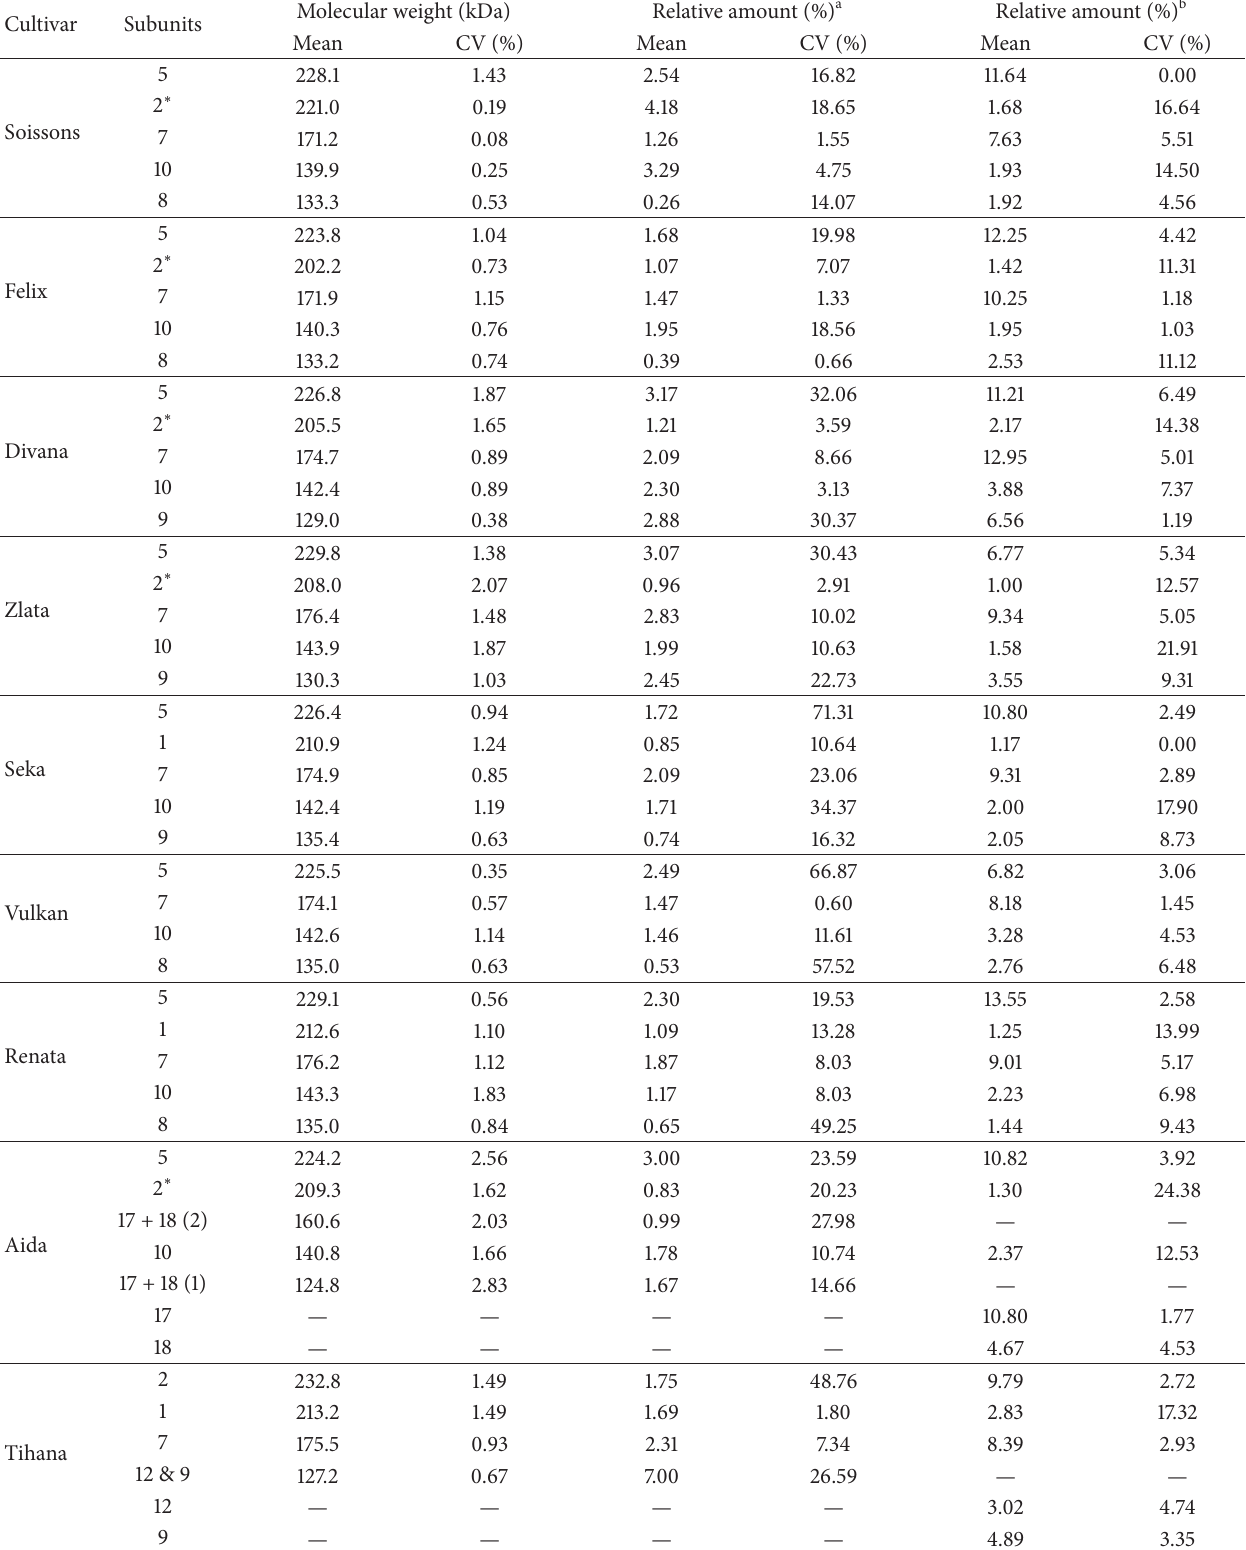
Table 2: Apparent sizes and quantification of individual HMW-GS subunits of nine bread wheat cultivars grown in Croatia by LoaC method and quantification of individual HMW-GS subunits by